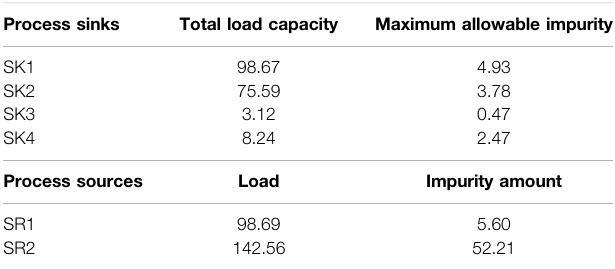
TABLE 2 | Characteristics of process sinks and sources of the case study-1. All loads refer to the target compound (dichloromethane) and the values to